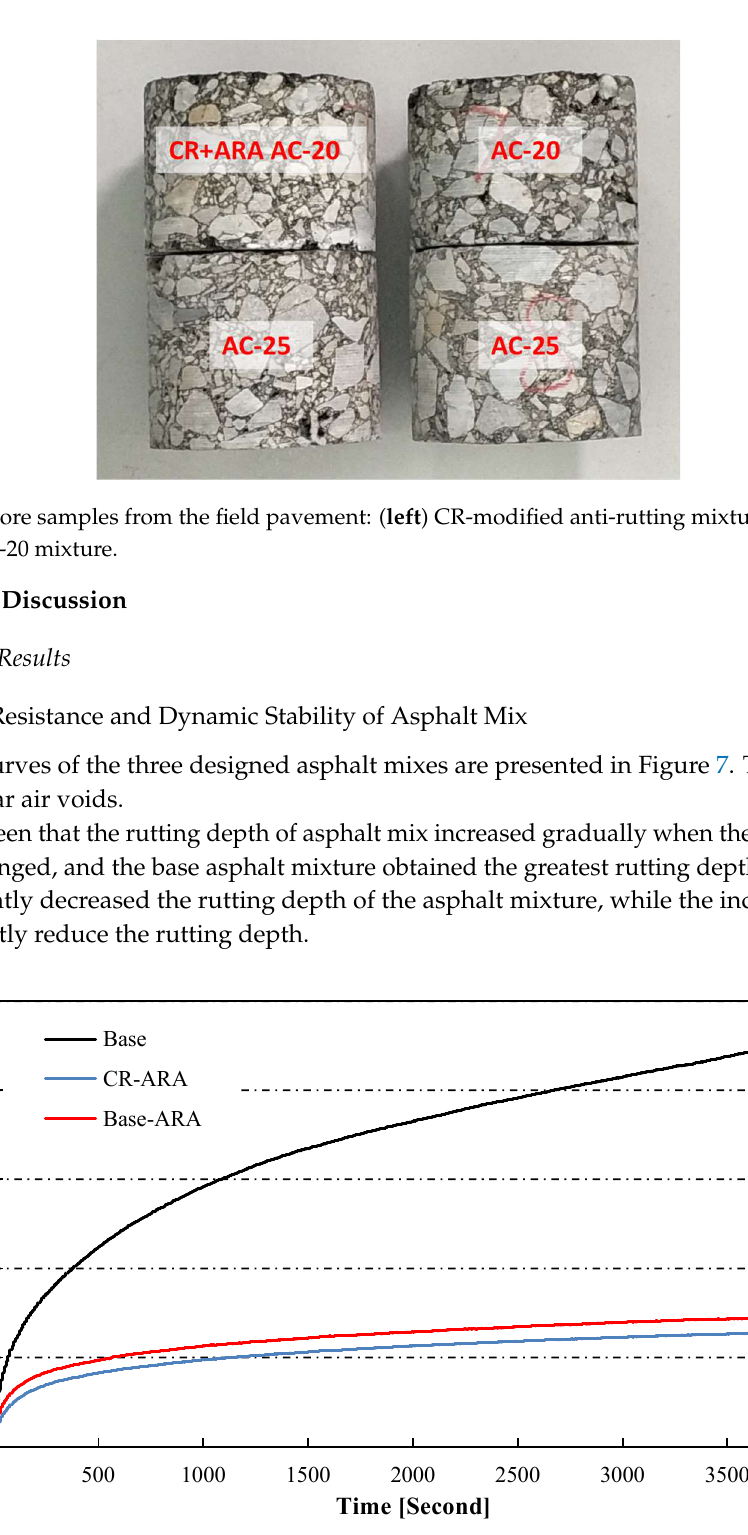
Figure 7. Rutting depth development in asphalt mixture slabs under repeated wheel tracking. Table 6. Dynamic stability of asphalt mix after wheel tracking test.